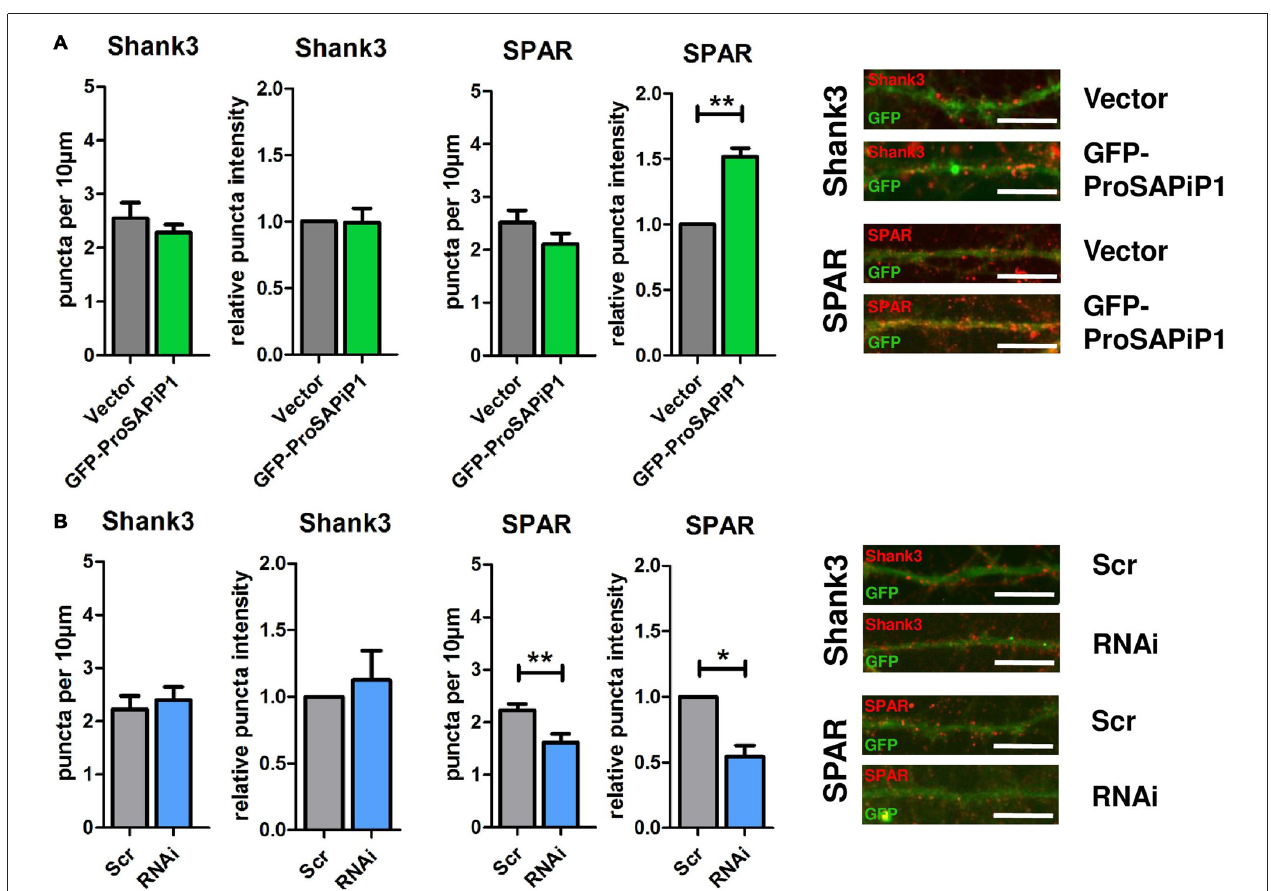
FIGURE 3 | Analysis of Shank3 and SPAR after ProSAPiP1 overexpression and knockdown in mature primary hippocampal neurons. (A) Primary hippocampal cultures were infected with either FUGW empty vector (Vector) or GFP-ProSAPiP1 and stained for Shank3 (red) or SPAR (red) on DIV28 as indicated. The intensity of SPAR-positive puncta was significantly increased. (B) Primary hippocampal cultures were infected with either Scr or RNAi and stained for Shank3 (red) or SPAR (red) on DIV28 as indicated. A significant reduction was observed in both density and intensity of SPAR positive puncta between Scr and RNAi. Scale bar: 10 µ m. Statistical analysis was performed using unpaired two-sided t -test. ∗ p < 0.05; ∗∗ p < 0.01. n = 15 neurons from three independent